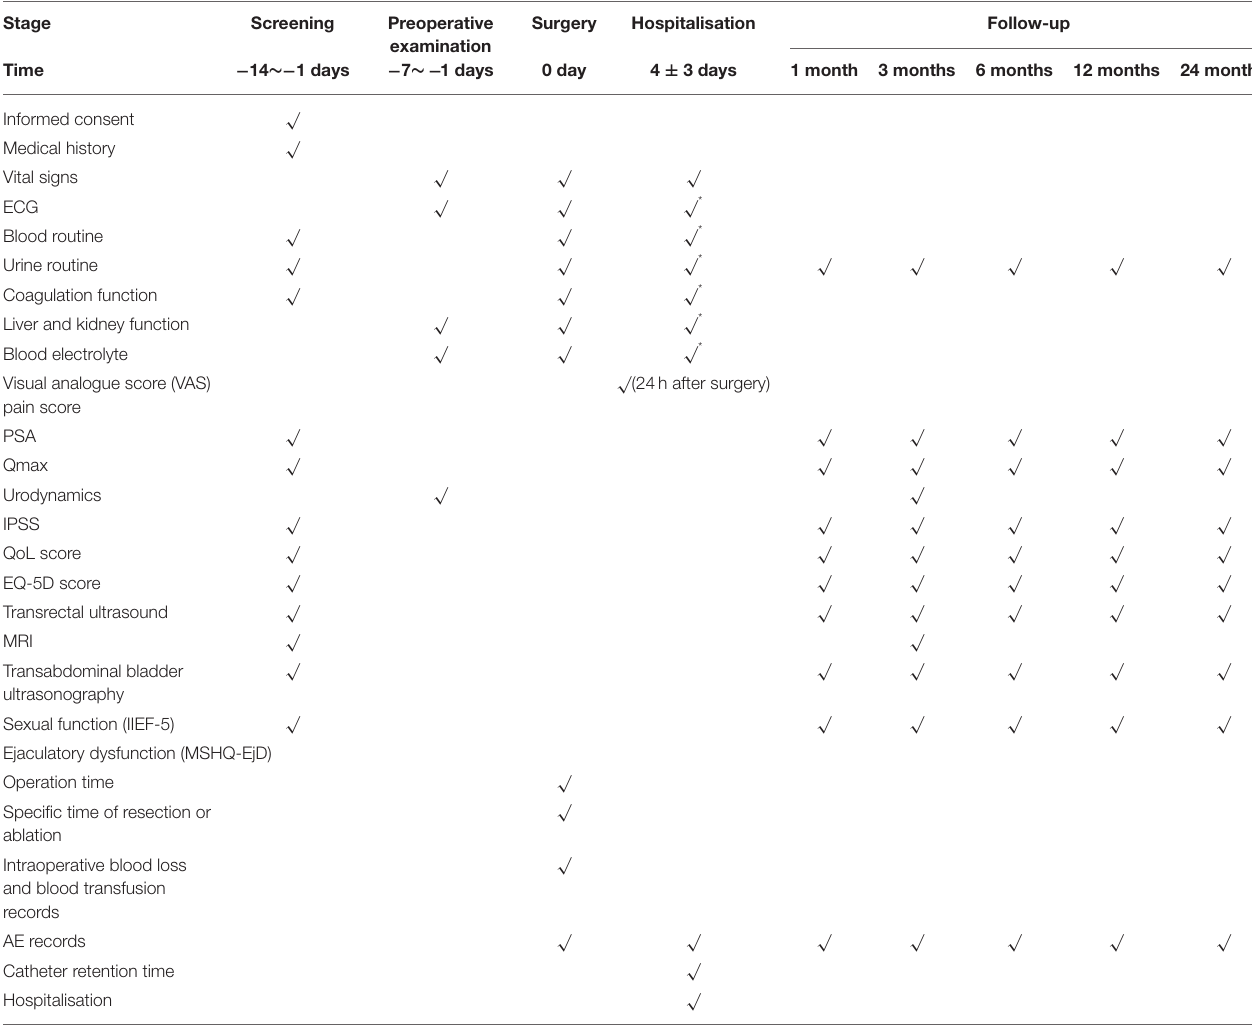
TABLE 1 | Contents of enrolments, interventions, and